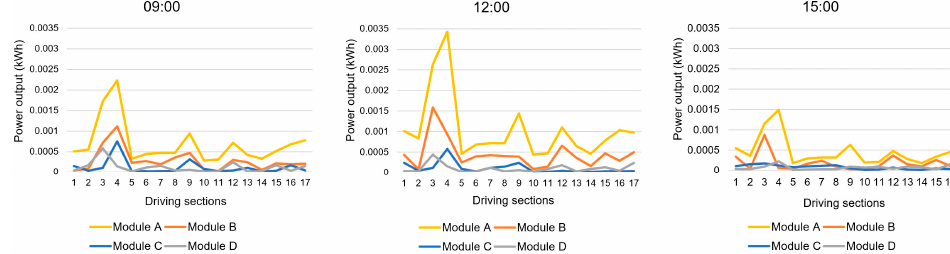
Figure 5. Graphs of PV potential of driving sections over time for all four modules.